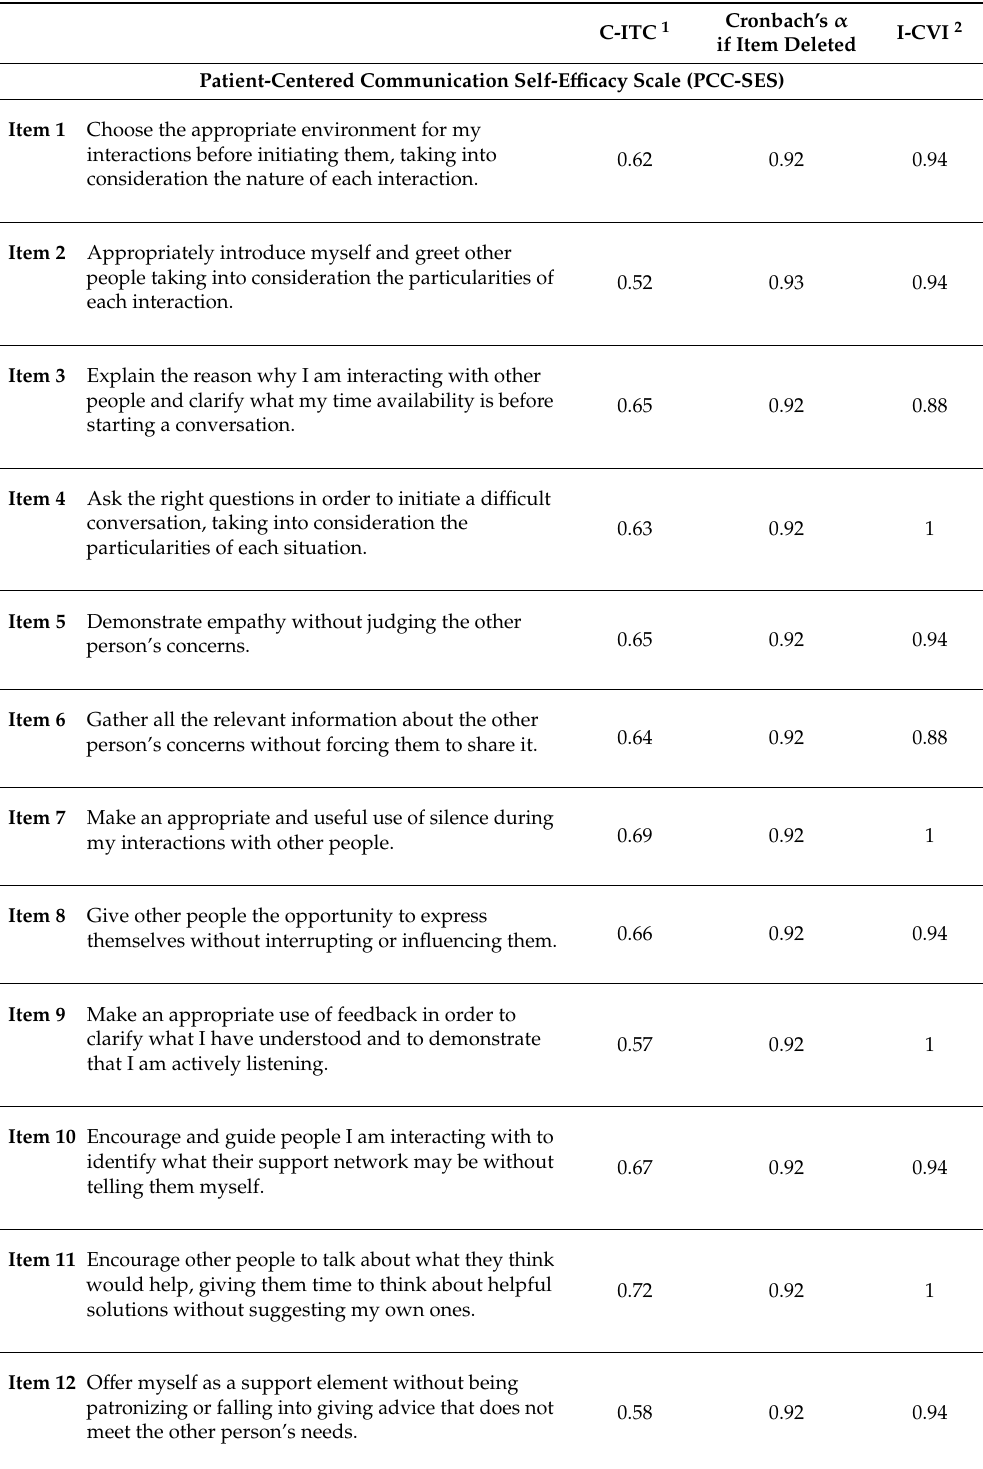
Cronbach’s α C-ITC 1 I-CVI 2 if Item Deleted